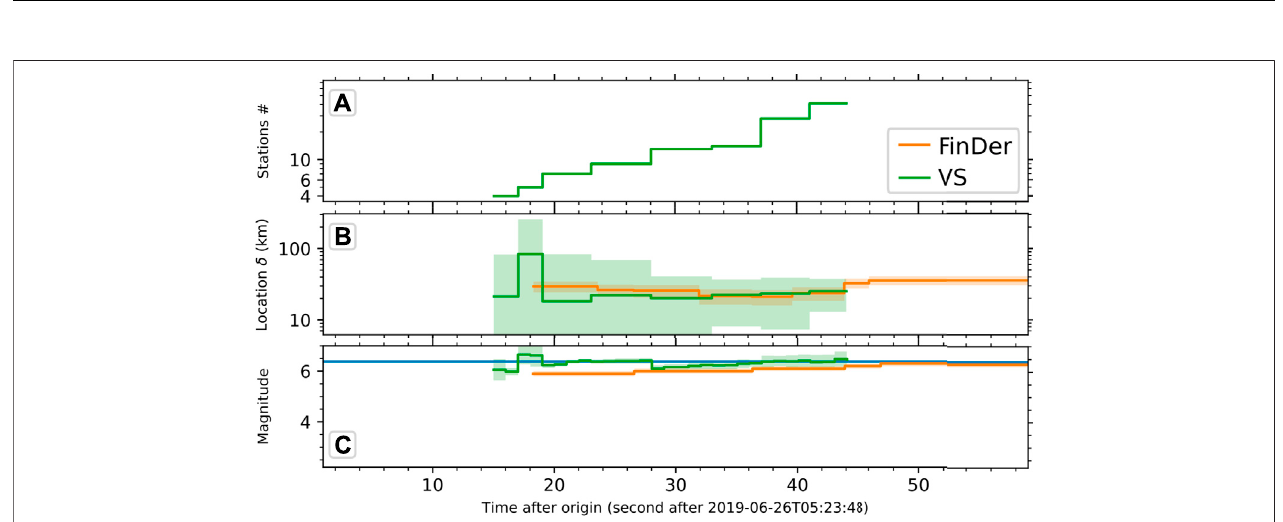
FIGURE6| Time evolutionofthe (A) number ofstations contributingtothelocation, (B) thelocationerror(km),and the (C) EEWmagnitude forthe2019Armuelles earthquake (Mw 6.4).